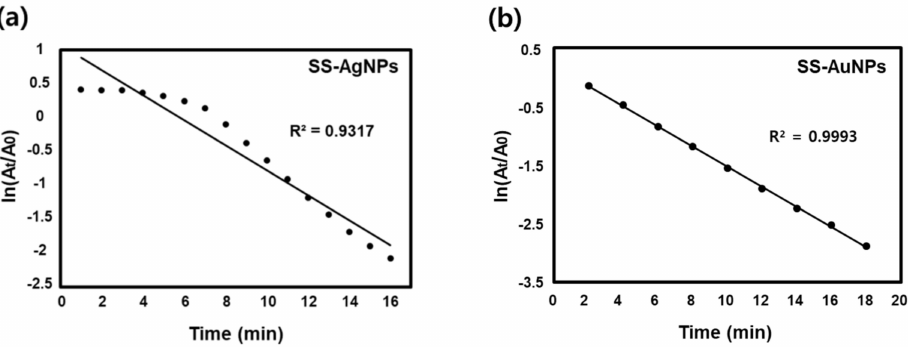
versus time during MO reduction by catalysts, ( a ) SS-AgNPs and ( b ) Figure 12. Plot of ln A t A 0